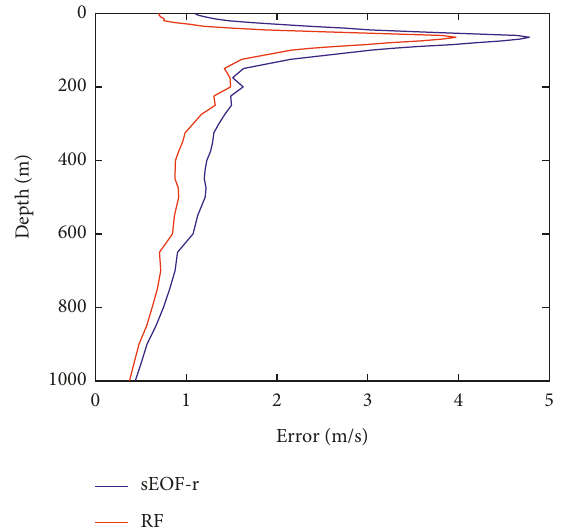
Figure 6: Reconstruction errors of the sEOF-r and RF models at different